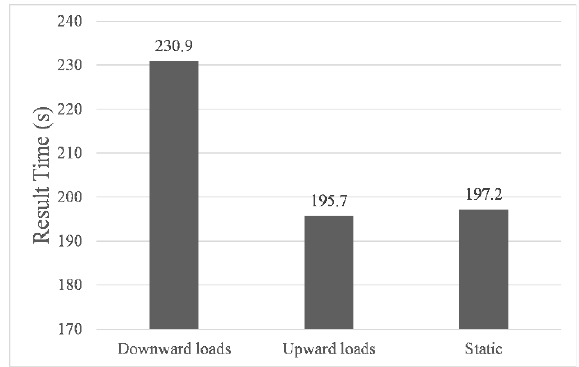
Figure 6. Navigation time.